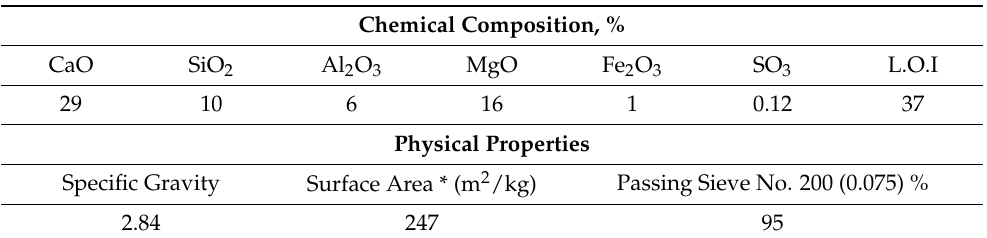
Table 3. Properties of the limestone dust used for mineral